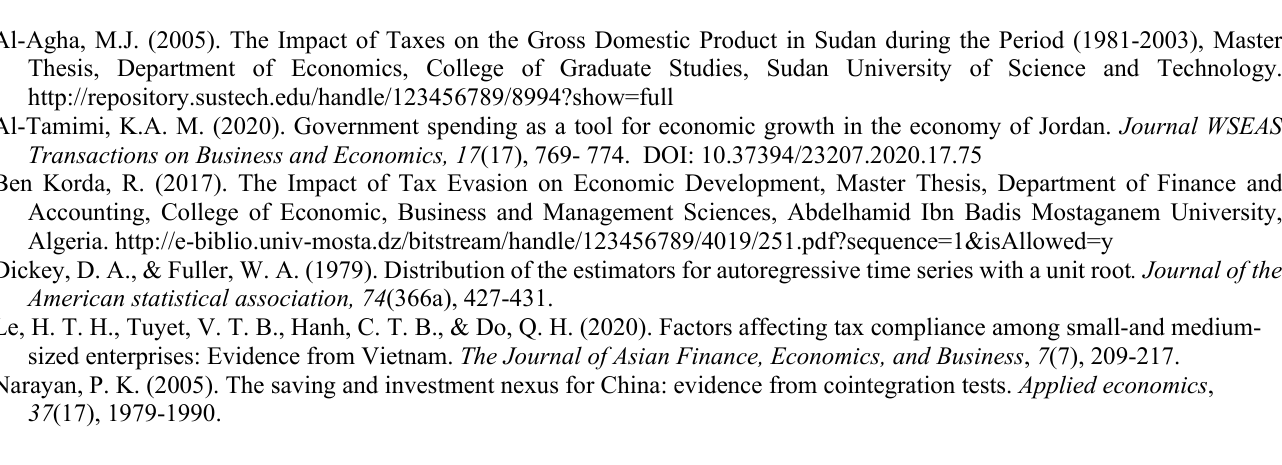
The impact of tax revenues on the gross domestic product in Jordan during the period (2000-2018) ** Significance at 0.01